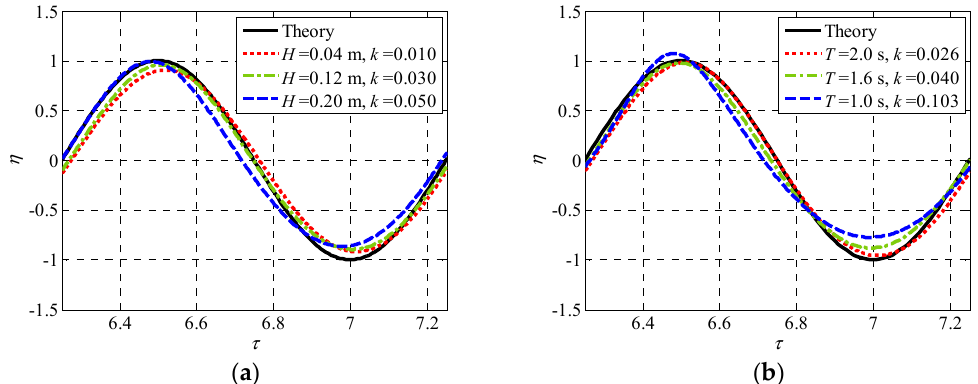
Figure 13. Non-dimensional free surface elevation as a function of the non-dimensional flow time at different wave steepness: ( a ) at T = 1.6 s; ( b ) at H = 0.16 m.